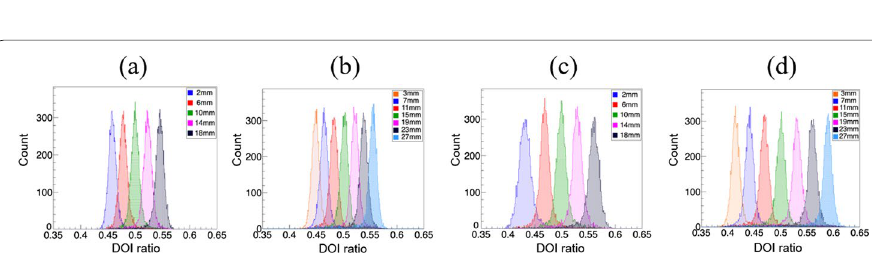
Fig. 9 DOI ratio histograms of a middle crystal in the four detectors measured at different depths of 4-mm stepping size, a detector 1, b detector 2, c detector 3, and d detector 4. The depths measured for detectors 1 and 3 are 2, 6, 10, 14, and 18 mm from one end. The depths measured for detectors 2 and 4 are 3, 7, 11, 15, 19, 13, and 27 mm from one